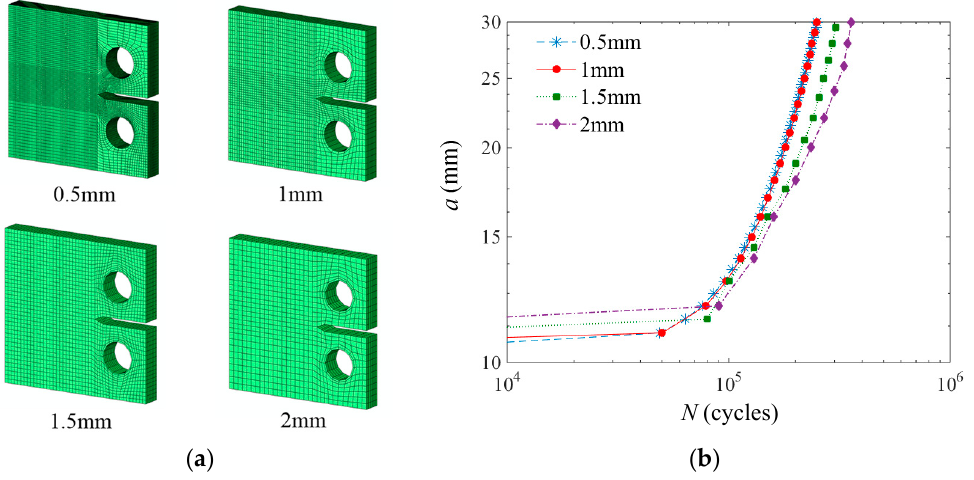
Figure 9. Effect of mesh size. ( a ) Mesh size; ( b ) a-N curve under different mesh sizes. The maximum principal stress distributions of the FCP process with a mesh size of 1mm under ∆ P = 15 kN and R = 0.1 are shown in Figure 10. The stress is large near the crack tip and decreases rapidly away from it. The stress at the crack tip increases with the degree of crack propagation. As shown in Figure 10b–d, the stress at the crack tip is about 500~2200 MPa at the steady crack propagation stage. When the model is approaching the fracture point, the stress reaches 1.2 × 10 5 MPa, as shown in Figure 10f. The increment number of cycles decreases while the crack propagation length remains constant, indicating that the growth rate of the fatigue crack increases.